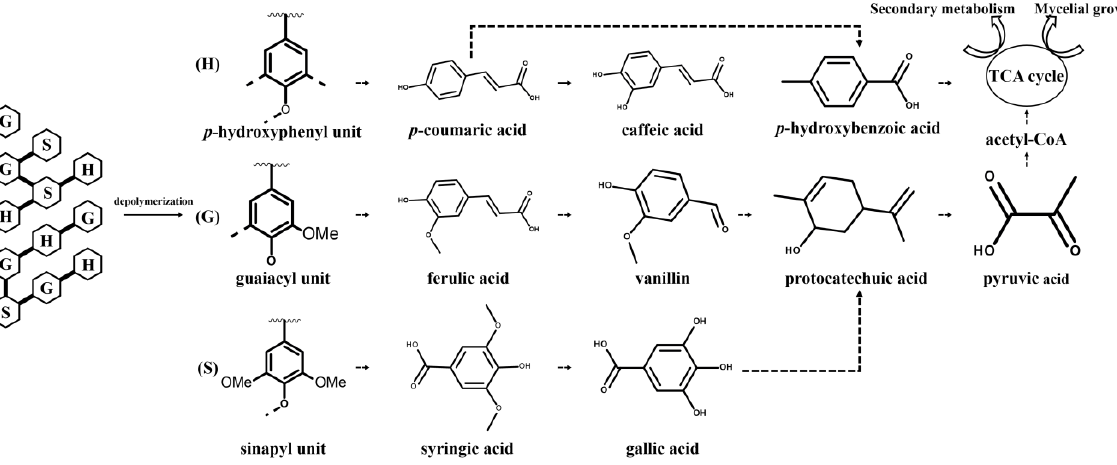
Figure 3. Schematic diagram of lignin degradation pathway in L. edodes . The dotted line represents an indirect reaction process. H, G, and S in the figure refer to three phenyl propane monomers of lignin, which named coumaryl alcohol (H), coniferyl alcohol (G), and sinapyl alcohol (S), respectively [49,50].